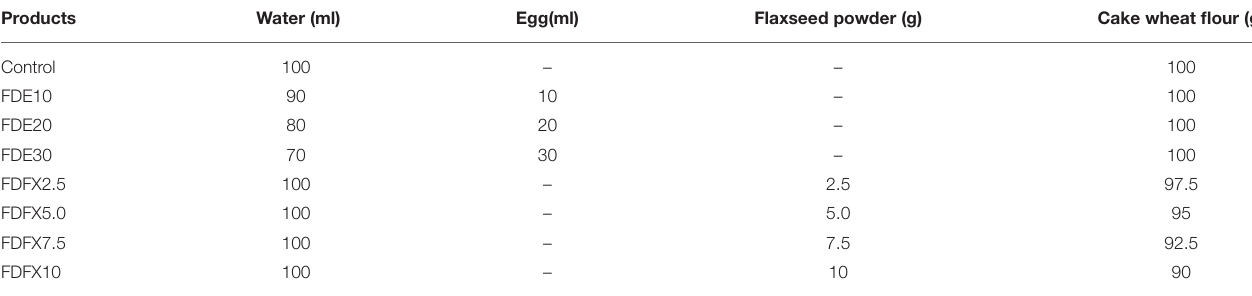
TABLE 1 | Formulations for fried dough